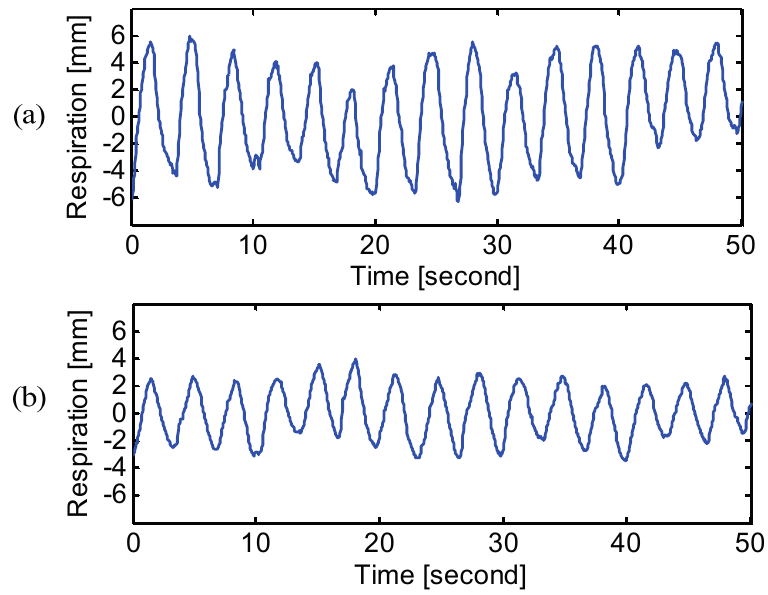
Figure 6. Radar measured signals at ( a ) chest and ( b ) abdomen when the subject was performing chest